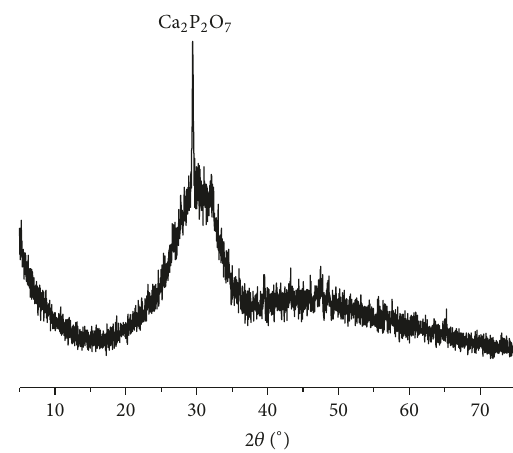
Figure 2: XRD pattern of the phosphorus